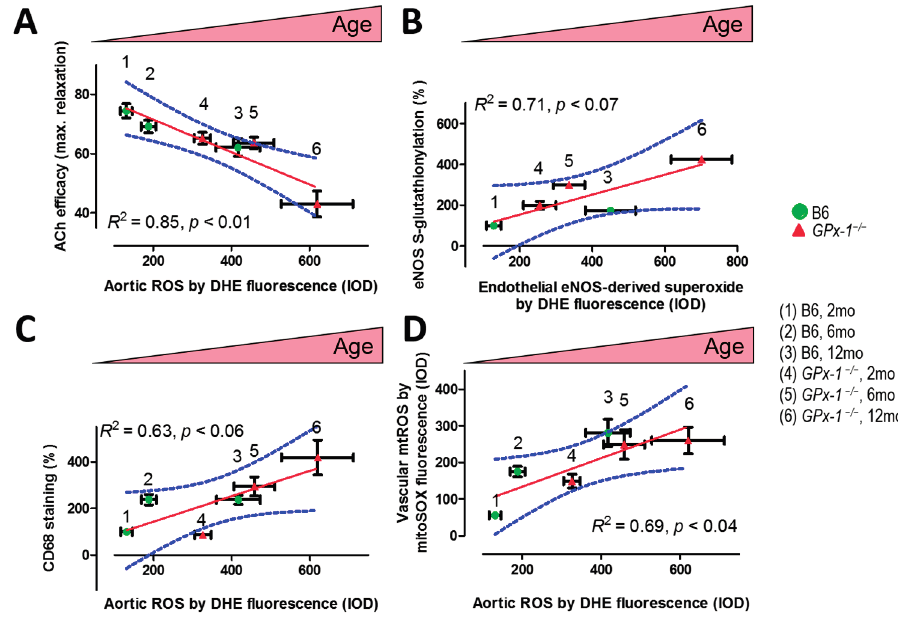
Figure 3. ( A ) Correlation between endothelium (ACh)-dependent relaxation (isometric tension measurement in isolated aortic ring segments) and aortic ROS formation (DHE staining of the aortic wall). Linear regression: p < 0.01, R 2 = 0.85; ( B ) Correlation between eNOS uncoupling marker ( S -glutathionylated eNOS) and endothelial (eNOS-derived) superoxide formation (endothelial DHE staining). Linear regression: p < 0.07, R 2 = 0.71; ( C ) Correlation between inflammation (CD68 staining) and aortic ROS formation (DHE staining of the aortic wall). Linear regression: p < 0.06, R 2 = 0.63; and ( D ) Correlation between mitochondrial ROS formation (mitoSOX staining) and aortic ROS formation (DHE staining of the aortic wall). Linear regression: p < 0.04, R 2 = 0.69. Linear regressions were performed with GraphPad Prism 6 for Windows (version 6.02). All data were collected from our previous work [16]. Each data point was based on measurement of 4–10 animals. B6 means C57/BL6 wild type control; GPx-1 − / − means glutathione peroxidase-1 knockout mice on C57/BL6 background. The age of measured groups increases from the left to the right. The solid red lines are simple linear regression fits to the data. Blue lines are the 95% confidence intervals on the estimated means. With permission of Wolters Kluwer Health, Inc. Copyright © 2014, Wolters Kluwer